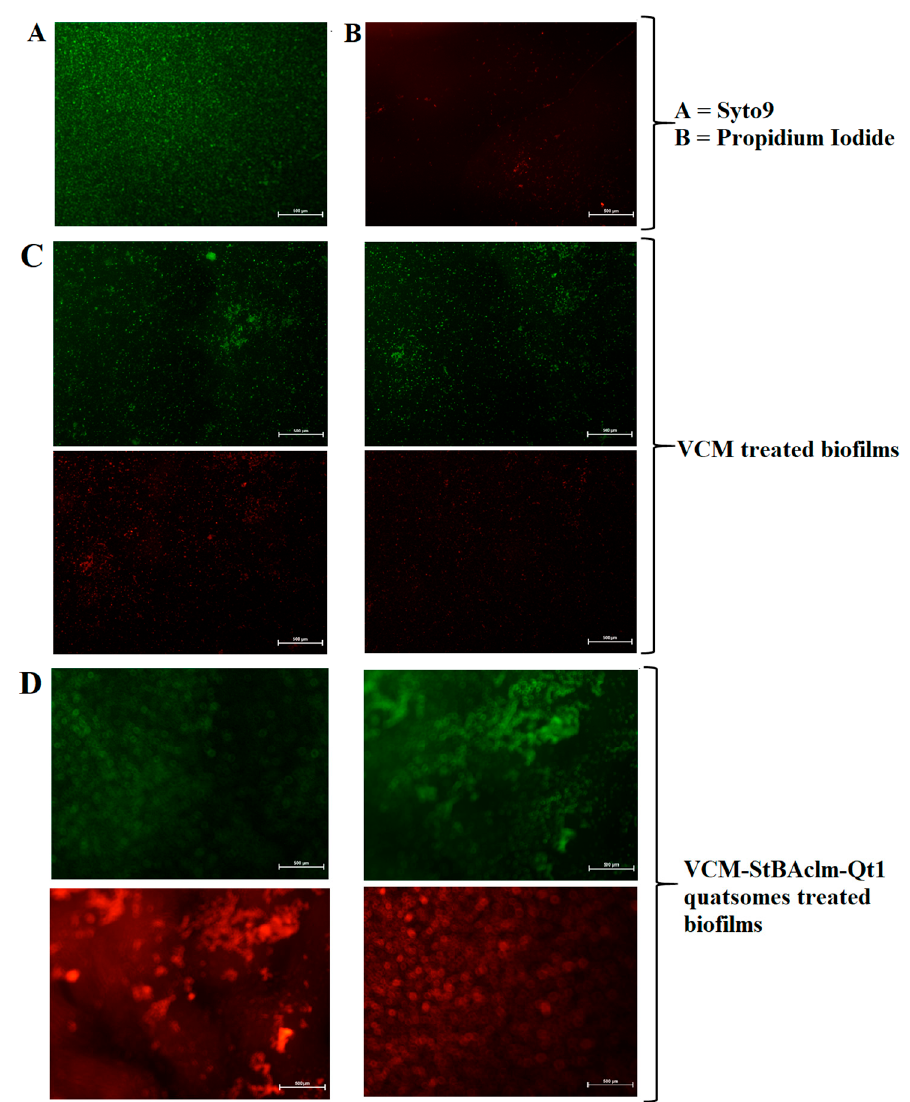
Figure 9. Fluorescence microscopy images of MRSA biofilm: ( A ) Untreated biofilms stained with Syto9. ( B ) Untreated biofilms stained with Syto9 and propidium iodide. ( C ) VCM-treated biofilms.